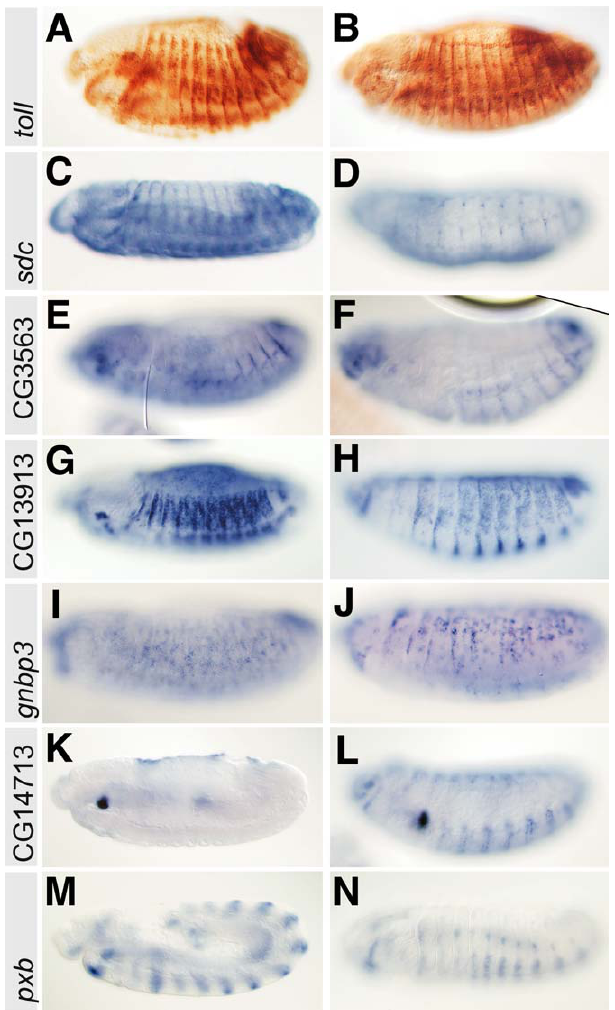
Figure 3. Expression Patterns of Genes that Cause a Gain-of-Function Muscle Phenotype Lateral views of embryos at stage 11 (M), stage 13 (A, C, E, G, I, K, and N), and stage 16 (B, D, F, H, J, and L) that were stained with transcript- specific anti-sense RNA probes or with anti-Toll antibodies (A and B). Note the expression of Toll (A and B) in segment border cells, sdc (LD08230) (C and D) in trachea, segment border cells, and the differentiated apodemes, CG3563 (LD15689) (E and F) in the apodeme precusor cells at the segment border, CG13913 (RE53394) (G and H) and CG5008/ gnbp3 (SD21560) (I and J) in a subset of apodeme precursors and cells of the epidermis, CG14713/14714 transcripts (AT17253) (K and L) in the dorsal and ventral epidermis around the segment border, and pxb (SD26190) (M and N) in intrasegmental epidermal stripes. DOI: